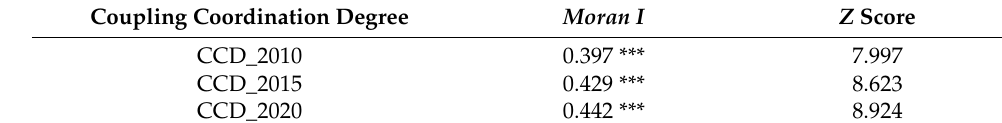
Table 6. Moran’s I of the coupling coordination degree.